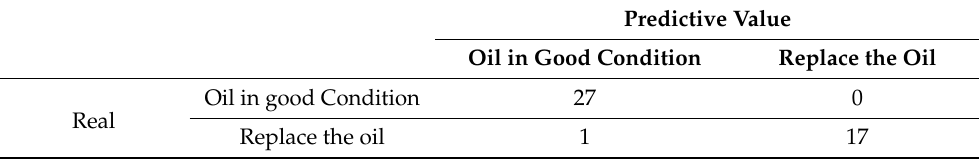
Table 4. Lubricating oil results (Confusion